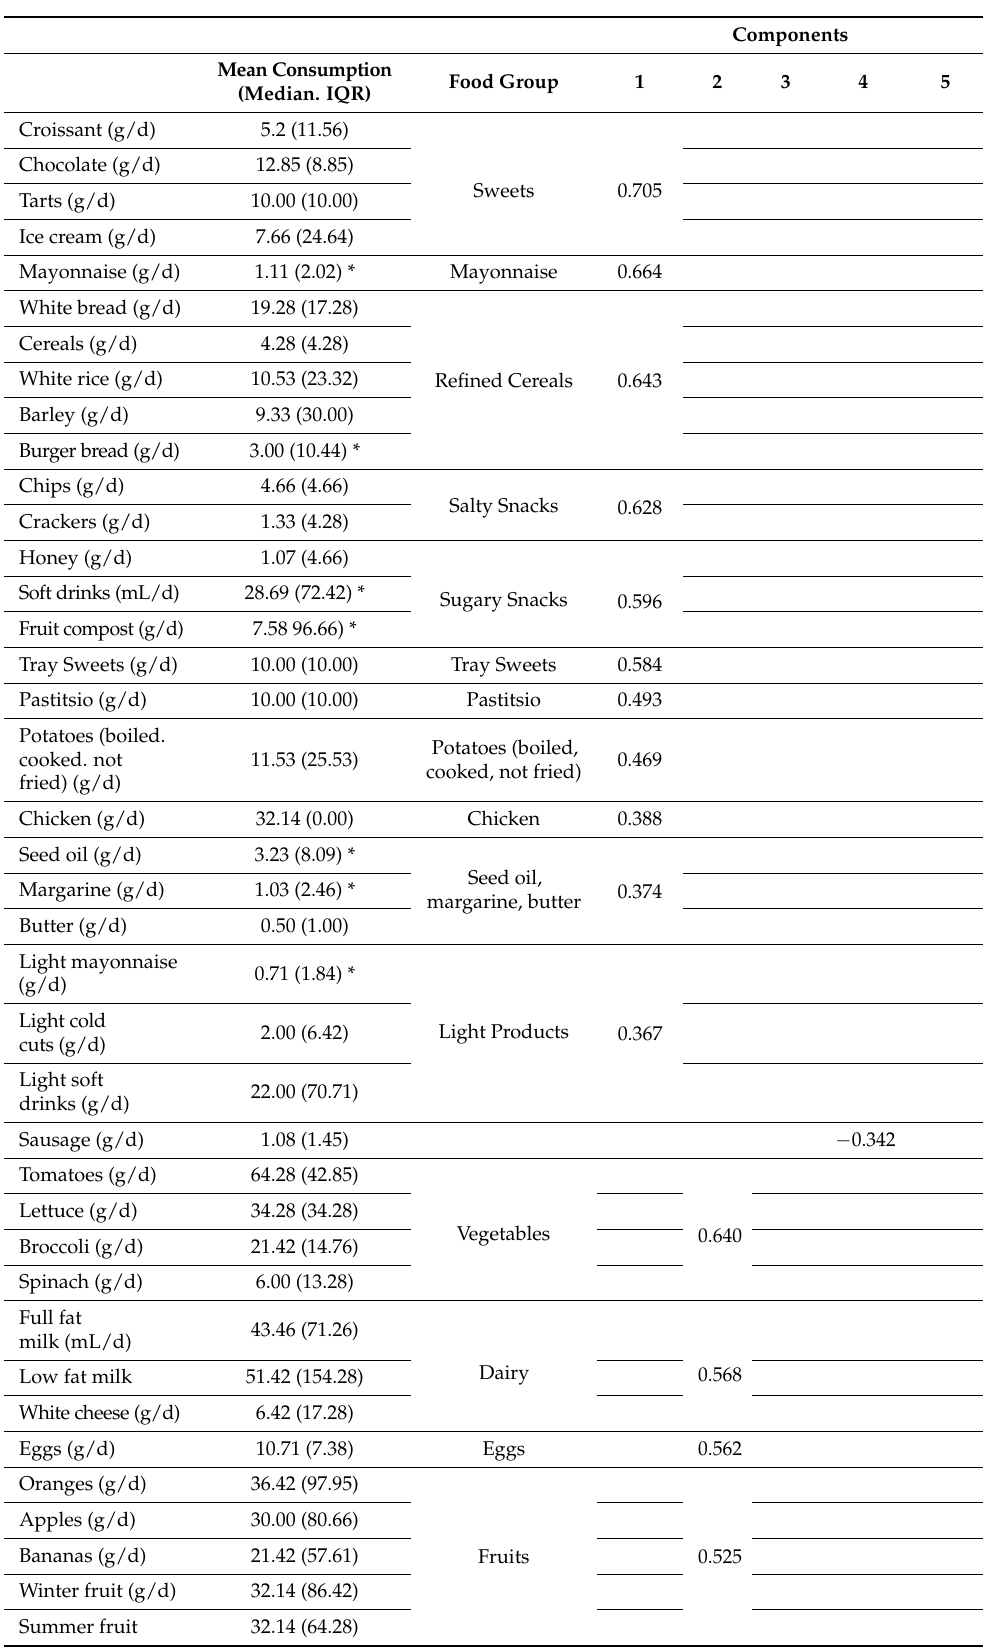
Table 4. Mean consumption and PCA factor loadings of the 32 FFQ-derived food